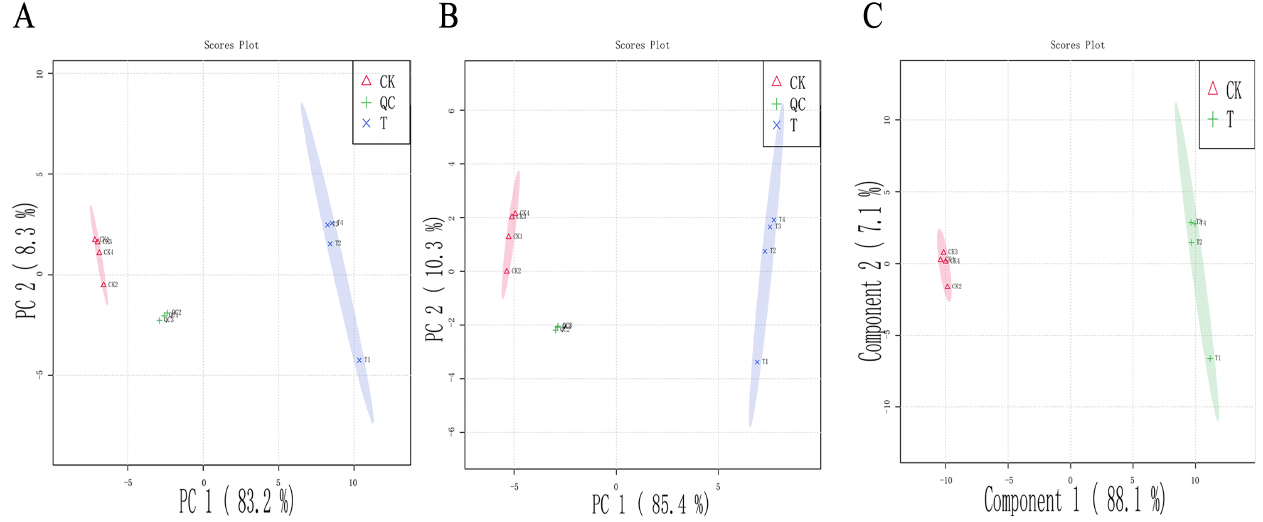
Figure 7. Multivariate cluster analyses of metabolic profiles of treated and control groups. ( A ): PCA plots with positive mode. ( B ) PCA plots with negative mode. ( C ) PLS-DA score plots. CK and T refer to DIW and PALA (0.2%) treatment, respectively.